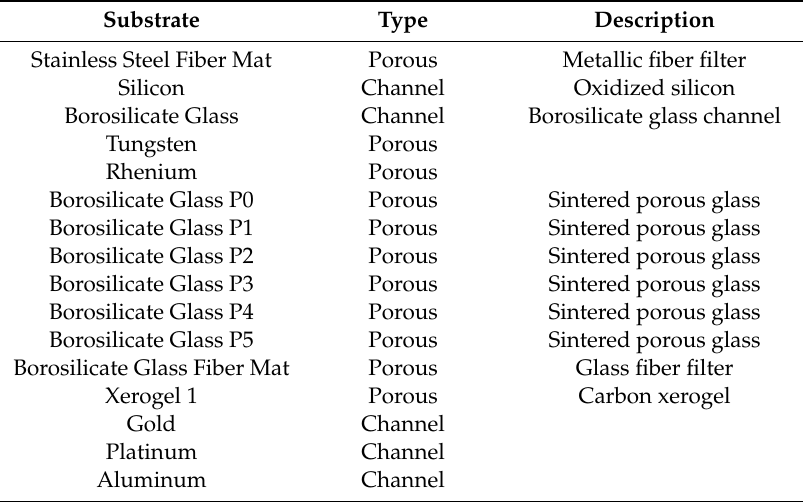
Table 2. List of substrates in the ESPET microfluidics database.